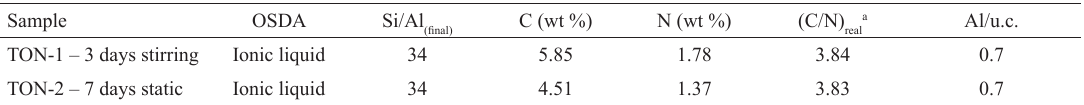
Table 1: Physico-chemical properties of the obtained zeolites with ionic liquid by method A. Sample